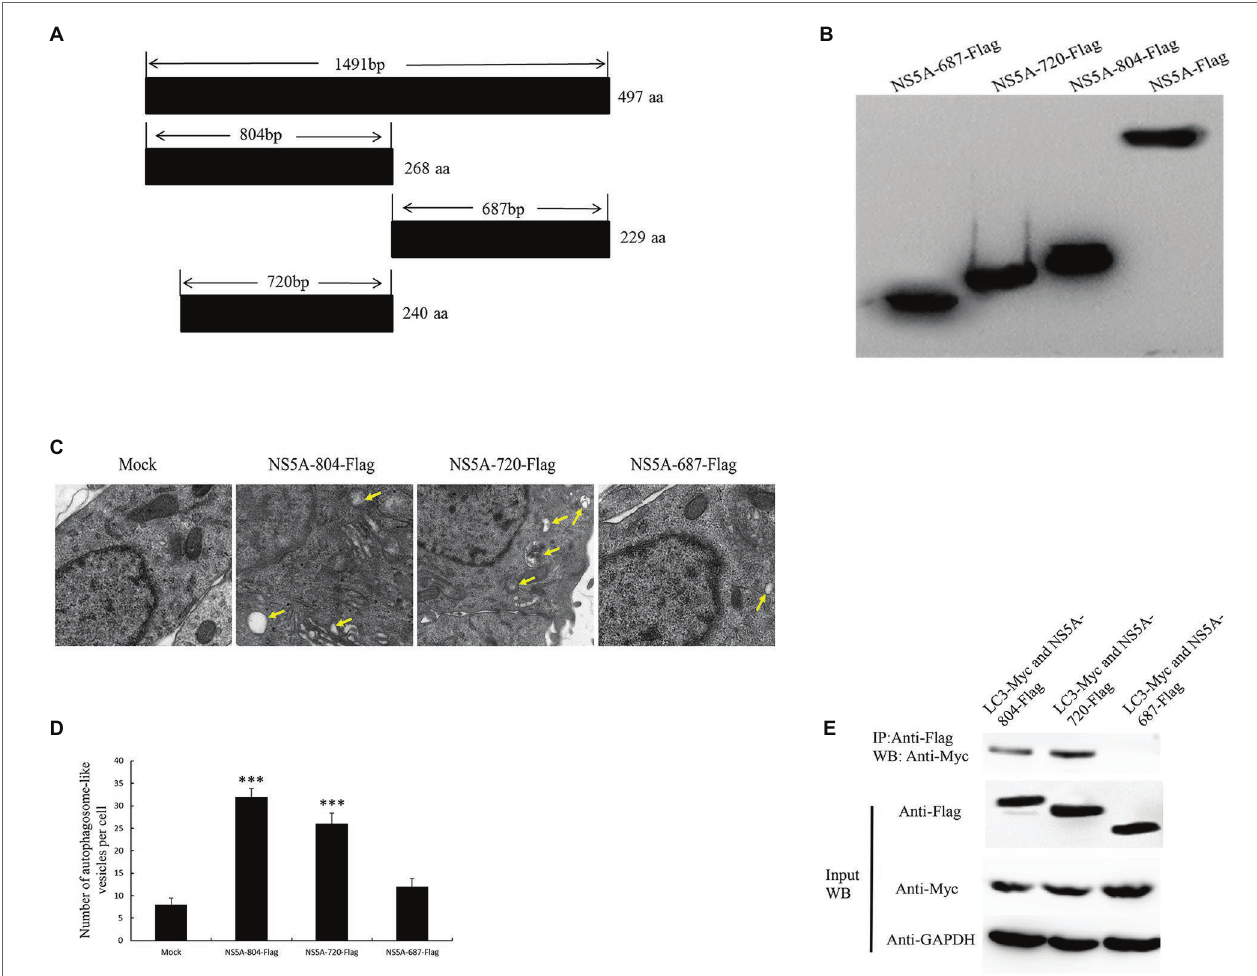
FIGURE 5 | The N-terminal region of NS5A increases the formation of autophagosome-like vesicles and is required for association with the LC3 protein. (A) Schematic representation of the protein domains of the CSFV NS5A protein. (B) Western blotting with anti-Flag antibody. (C) PK-15 cells were transfected with different parts of the NS5A-Flag vector and studied by electron microscopy. Yellow arrows indicate the structures with the characteristics of autophagosomes. (D) Quantification of autophagosome-like vesicles per cell image. The average number of vesicles in each cell was obtained from at least 10 cells undergoing each treatment. (E) The N-terminal region of CSFV NS5A interacts with LC3. PK-15 cells were transfected with different parts of the NS5A-Flag and LC3-Myc plasmids for 48 h and harvested. Cell lysates were immunoprecipitated with an antibody against Flag followed by Western blotting analysis. The data represent the mean ±